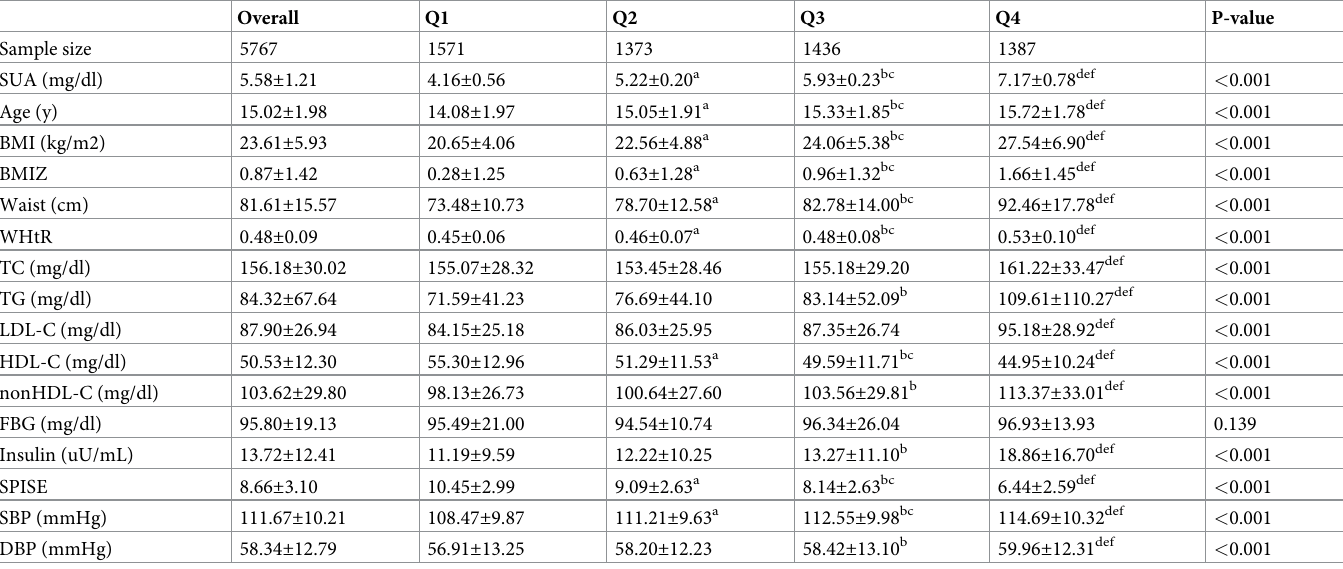
Table 2. Clinical characteristics and cardiometabolic risk factors by quartiles of serum uric acid in males.